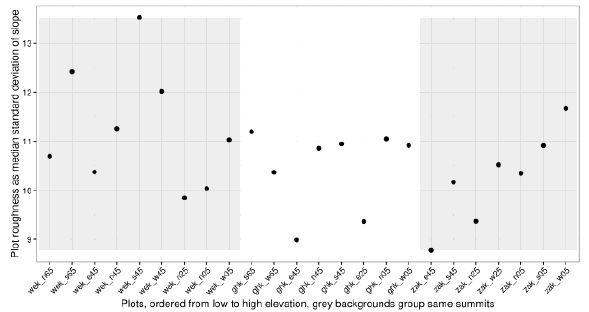
Figure 8. Plot roughness as the mean standard deviation of slope. Moving window size is 9x9 pixels.